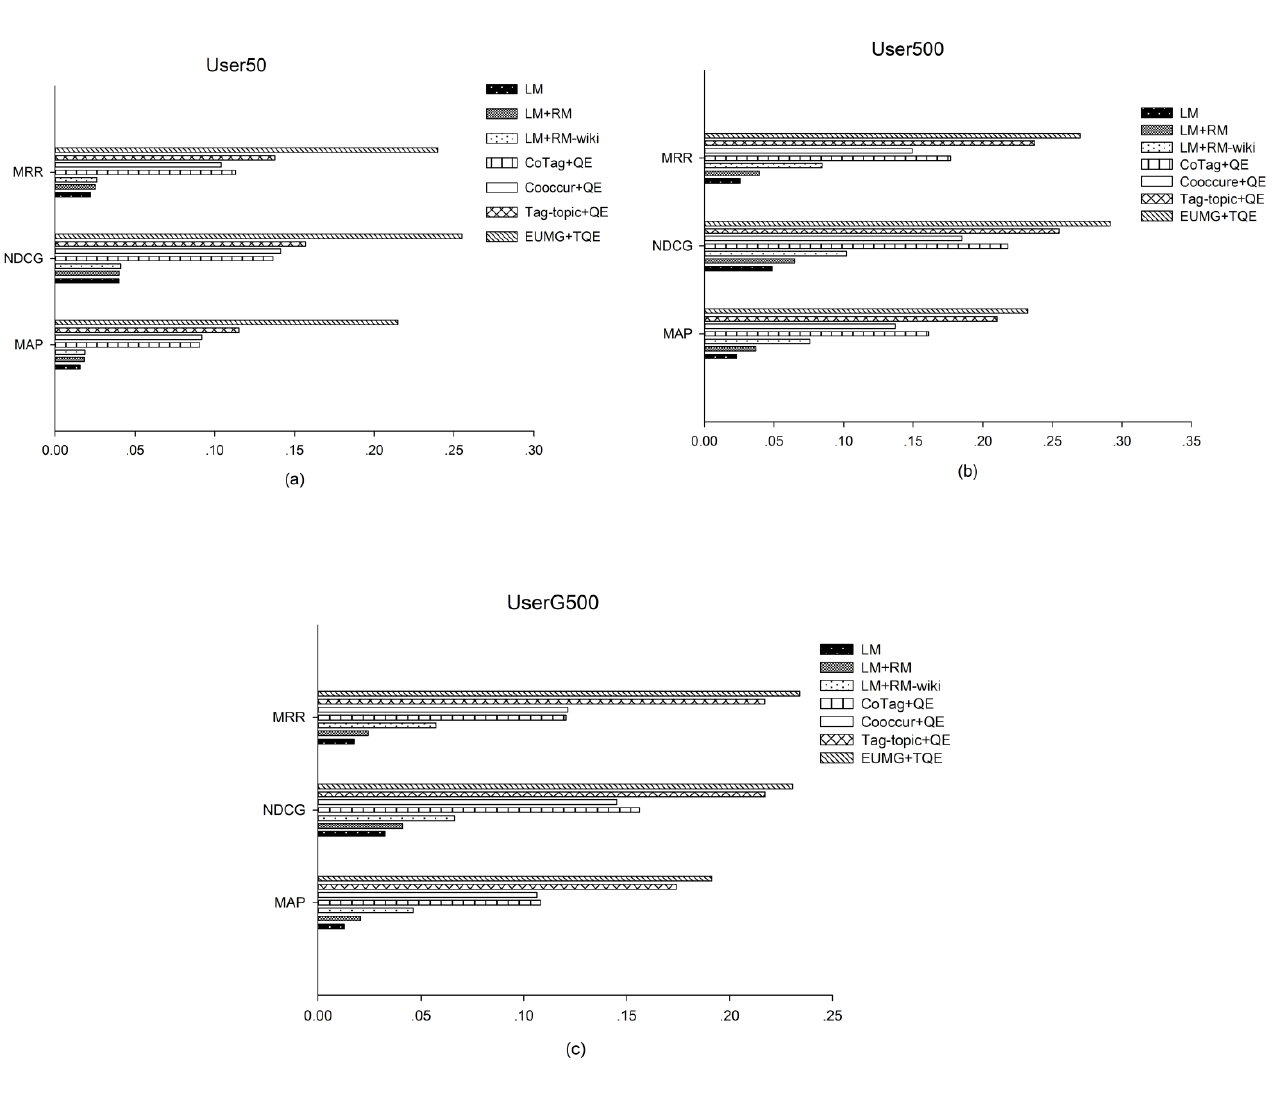
Fig. 2 . Results on the test users in the BIB